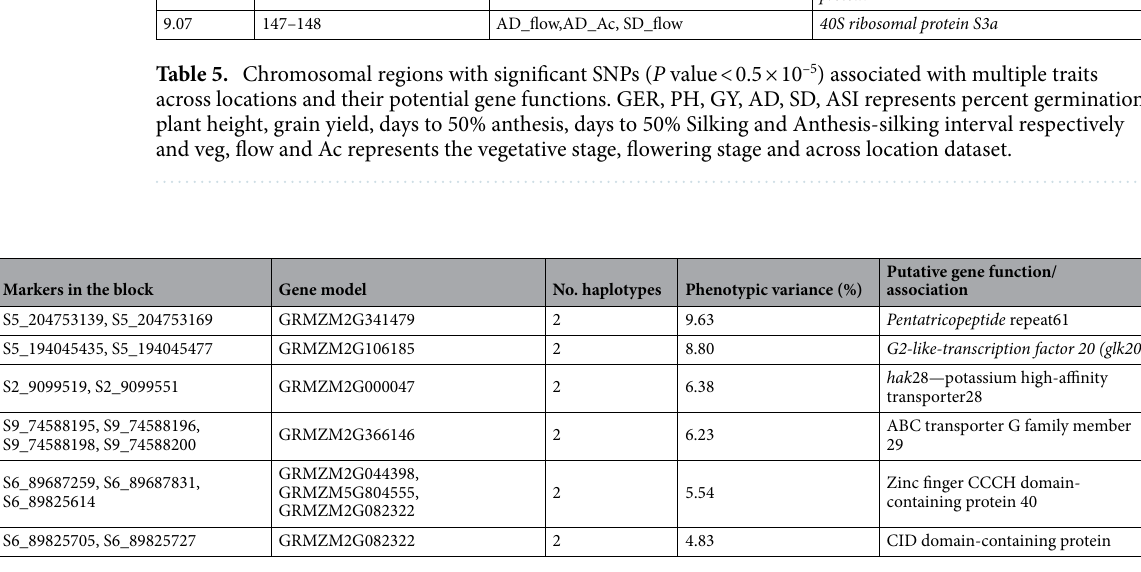
Table 6. Significant haplotypes identified for grain yield across